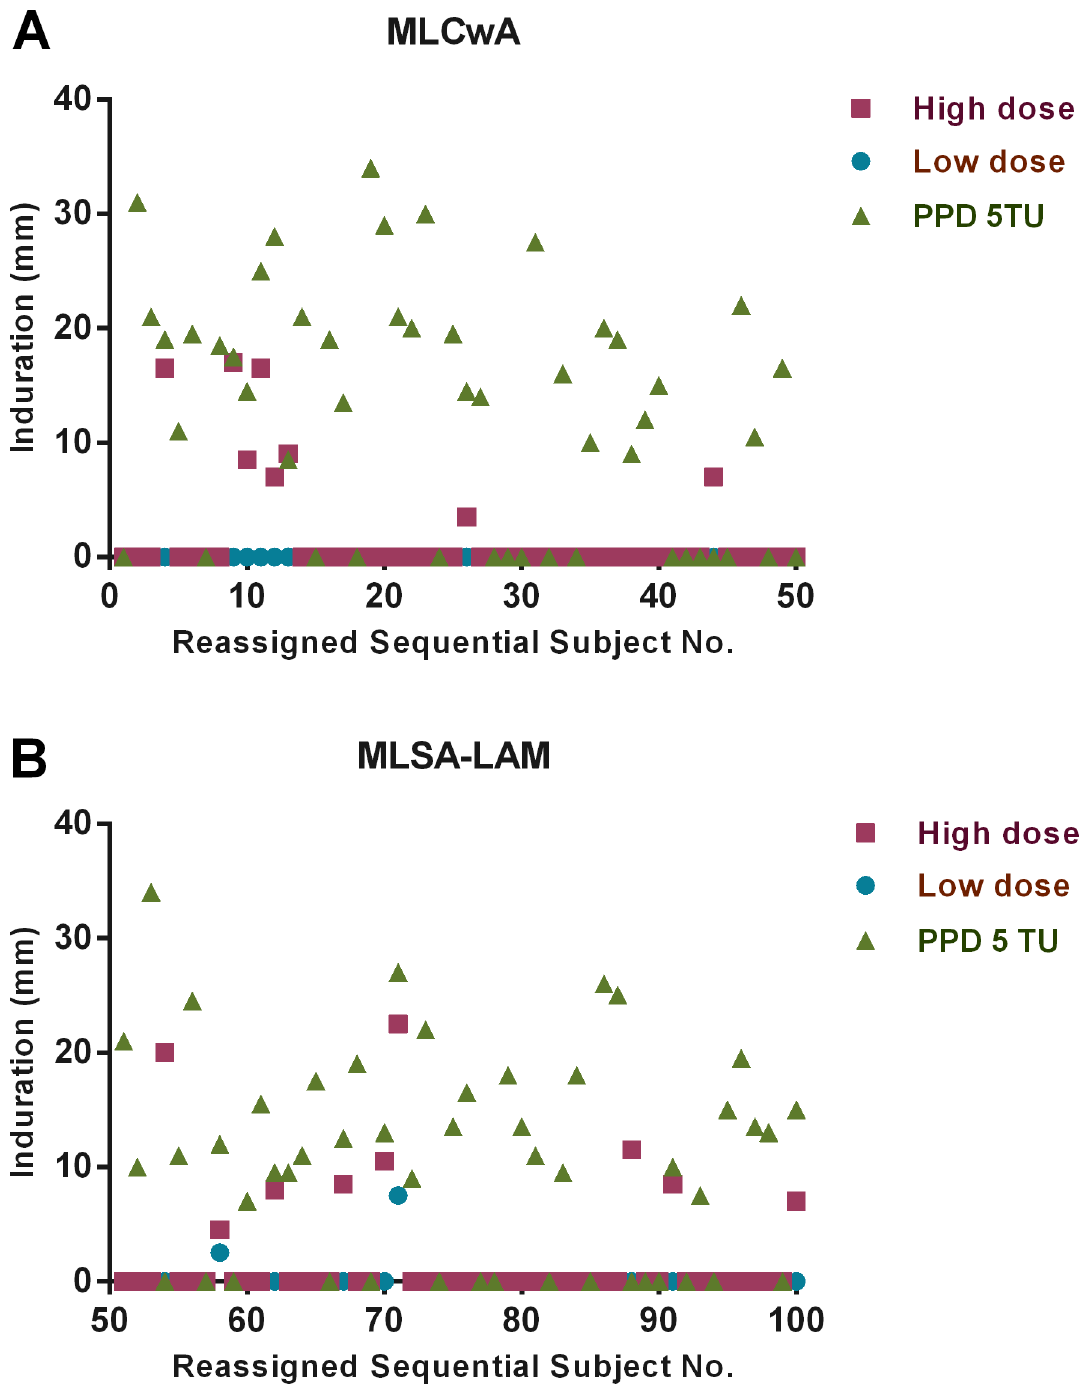
Figure 2. Phase II, Stage A/B – DTH induration by subject. Phase II, Stage A/B graph depicting DTH indurations elicited by leprosy skin test antigens at the high dose (1.0 m g) and low dose (0.1 m g), and PPD at 5 TU: A) MLCwA, and B) MLSA-LAM. The first five subjects on both graphs represent subjects from Stage A, and the remaining 45 subjects on both graphs represent subjects from Stage B.